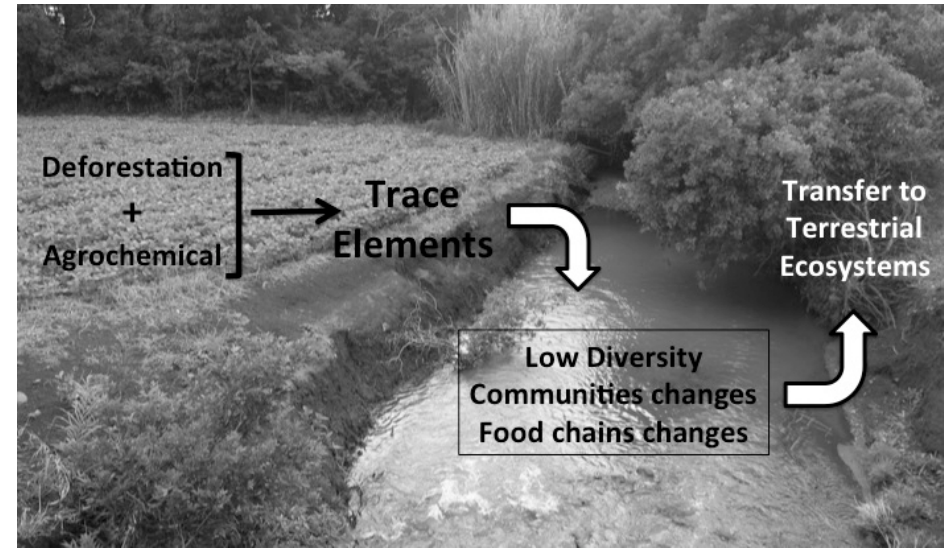
Figure 1. Route of contamination in streams/riparian zone by trace elements from agricultural practices and their transfer to the terrestrial